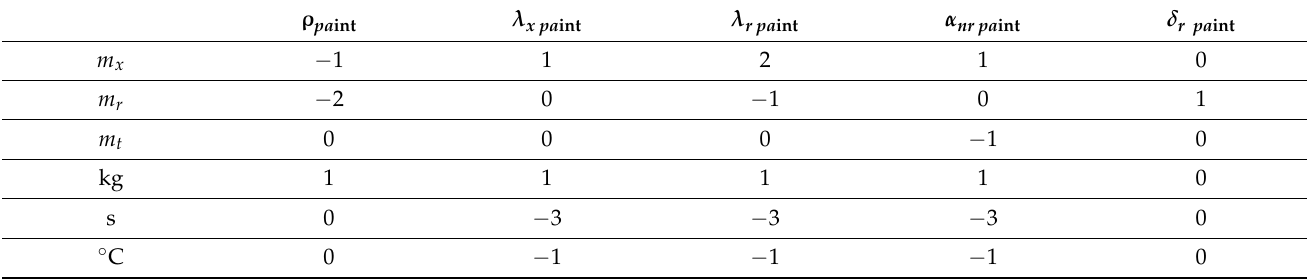
Table 6. The properties of the intumescent paint (part of matrix